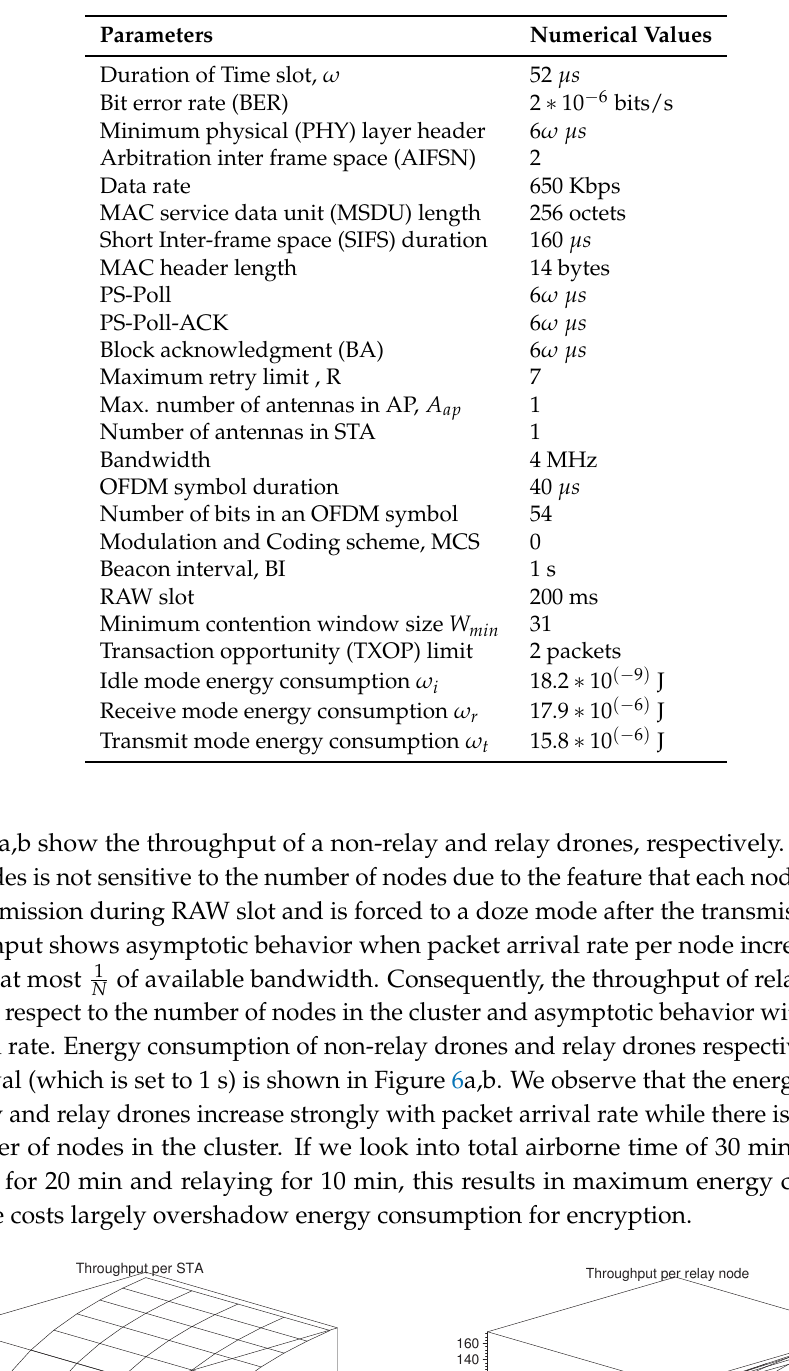
Table 2. Parameters for model of the UAV network at MAC level.